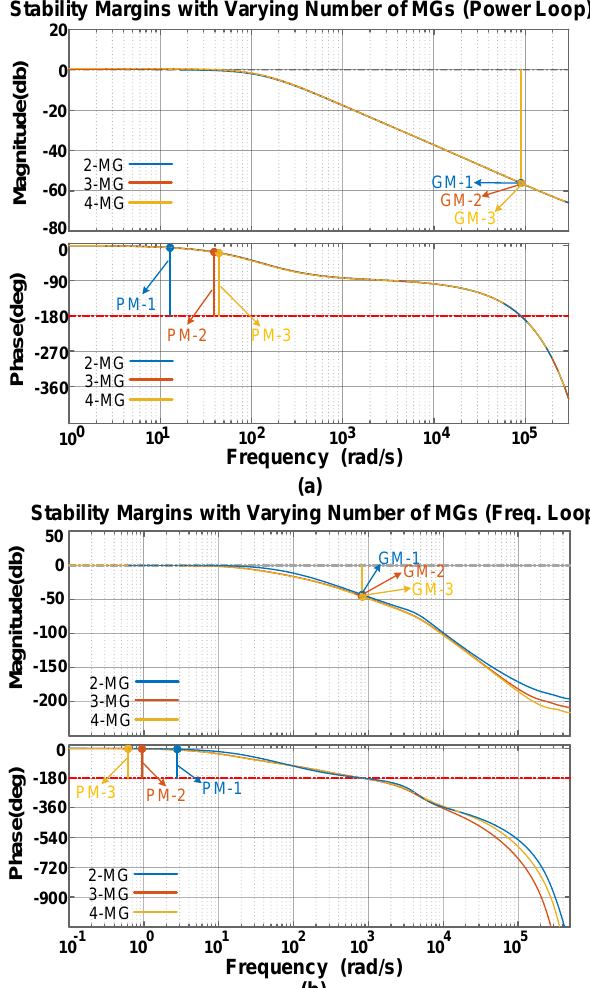
Figure 23. Sensitivity analysis by varying number of coupled MGs: ( a ) power control loop ( b ) fre- quency control loop.